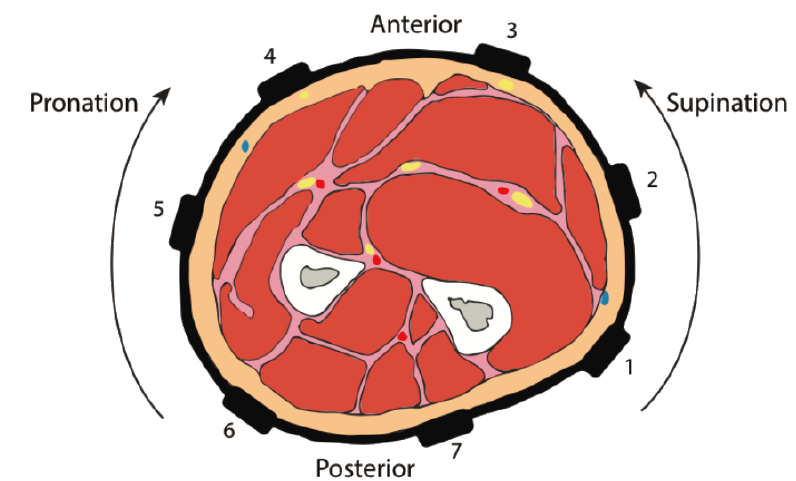
Figure 2. Schematic representation of the sensor band placed in the center configuration around a right forearm cross-section, looking toward the elbow. Figure reproduced with permission from Beckers et al.